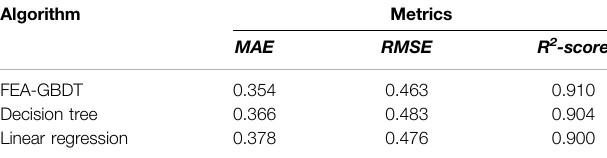
TABLE 6 | The data recovery results in real-world